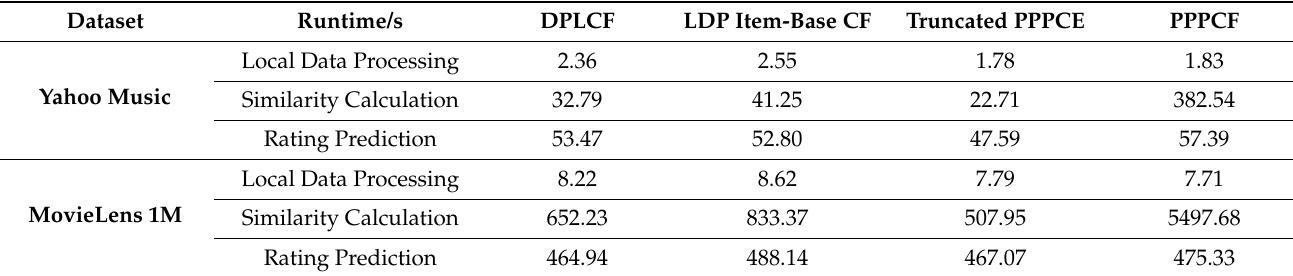
Table 3. Comparison of the time